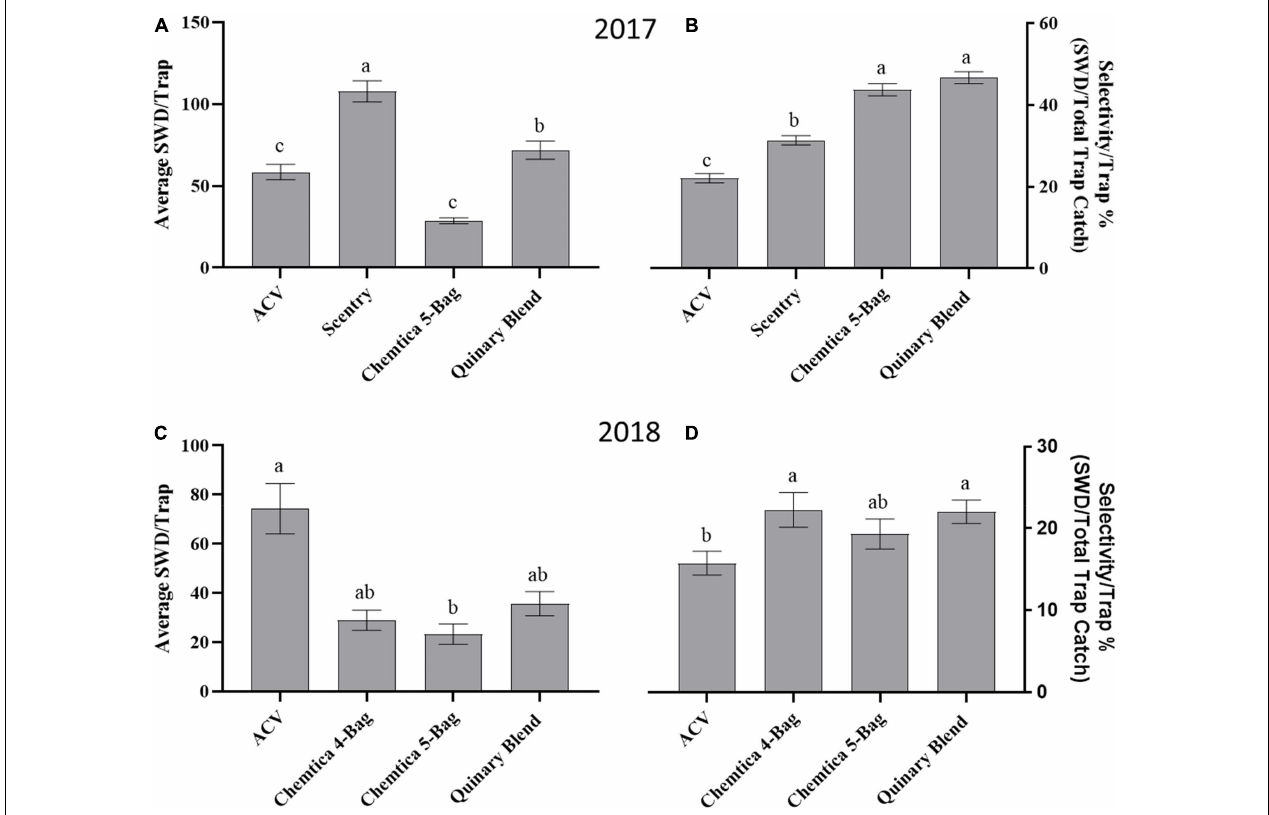
FIGURE 1 | Average SWD catch per trap and selectivity/trap over the entire trapping period in Maryland in a blueberry field in 2017 and 2018 by traps baited with ACV (apple cider vinegar), Scentry dispenser, ChemTica dispenser, and a quinary dispenser. (A) average catch in the blueberry field in 2017 ( N = 1330, df = 3, 379, F = 44.23, and P < 0.0001); (B) selectivity in the blueberry field in 2017 ( N = 1309, df = 3, 1305, F = 49.81, and P < 0.0001); (C) average catch in the blueberry field in 2018 ( N = 534, df = 3, 530, F = 3.092, and P = 0.0267); and (D) selectivity in the blueberry field in 2018 ( N = 530, df = 3, 526, F = 4.651, and P = 0.0032). Means separated by One-way ANOVA with a Tukey’s post-test. Error bars represent standard error. Different letters above bars in each subfigure indicate significant differences at α = 0.05. Data represented are untransformed.